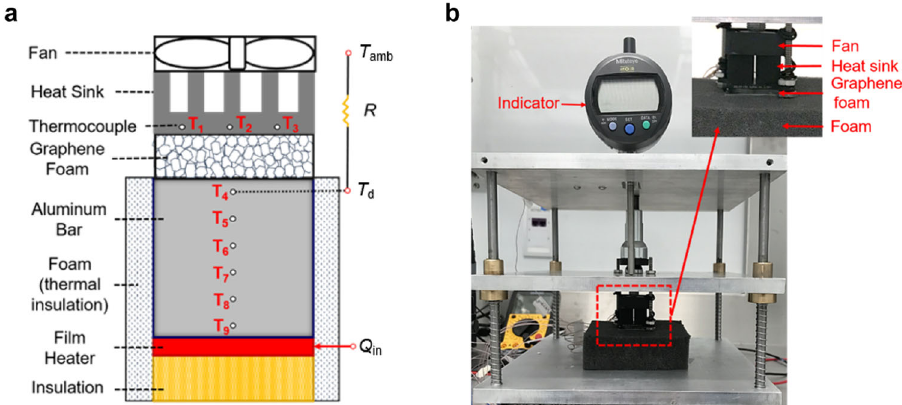
Fig. 4 Setup of the proof-of-concept experiment in an environmental chamber. a Schematic and b Photo of the performance test set-up. A fi lm heater is used to mimic a device and placed on a block of hard polymer foam insulation to minimize heat dissipation through the baseplate. An aluminum bar (1 ” × 1 ” in cross-section and 0.8 ” tall) is placed above the heater with 6 thermocouples to quantify the heat fl ow. The thickness of the graphene foam, inserted between the aluminum bar and the heat sink, can be controlled by moving the middle plate shown in panel b . An indicator measures the movement of the middle plate and is related to the thickness of graphene foam. The temperature of the top thermocouple (T 4 ), which is 0.1 ” from the surface, is taken as the device temperature for the calculation of thermal regulation to remove the effect of the added aluminum bar. Three thermocouples additional are distributed within the base of heat sink. Another thermocouple, fl oating in the air, measures the ambient temperature. The whole system is contained within an environmental chamber where the ambient temperature can be adjusted from 0° to 30